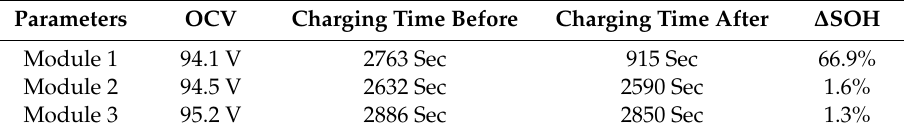
Table 2. Constant current (CC) end time according to battery state. Figure 18. Charging time profile according to battery state.